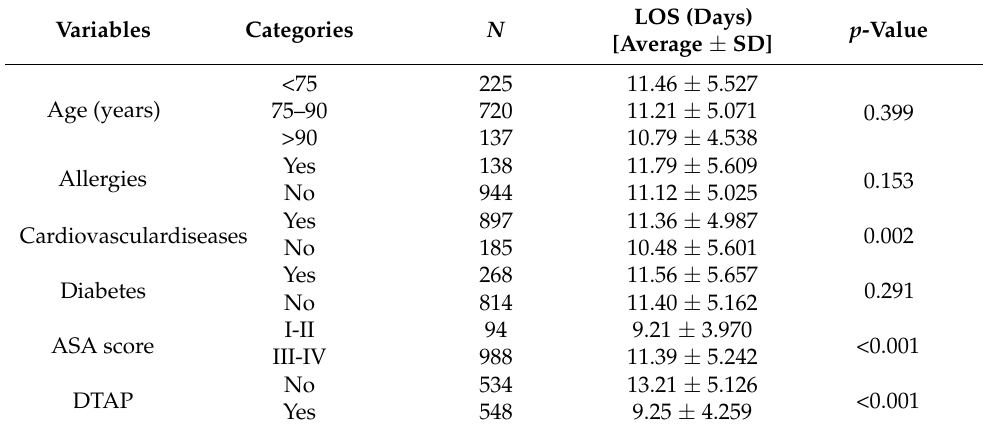
Table 1. Descriptive statistics of the